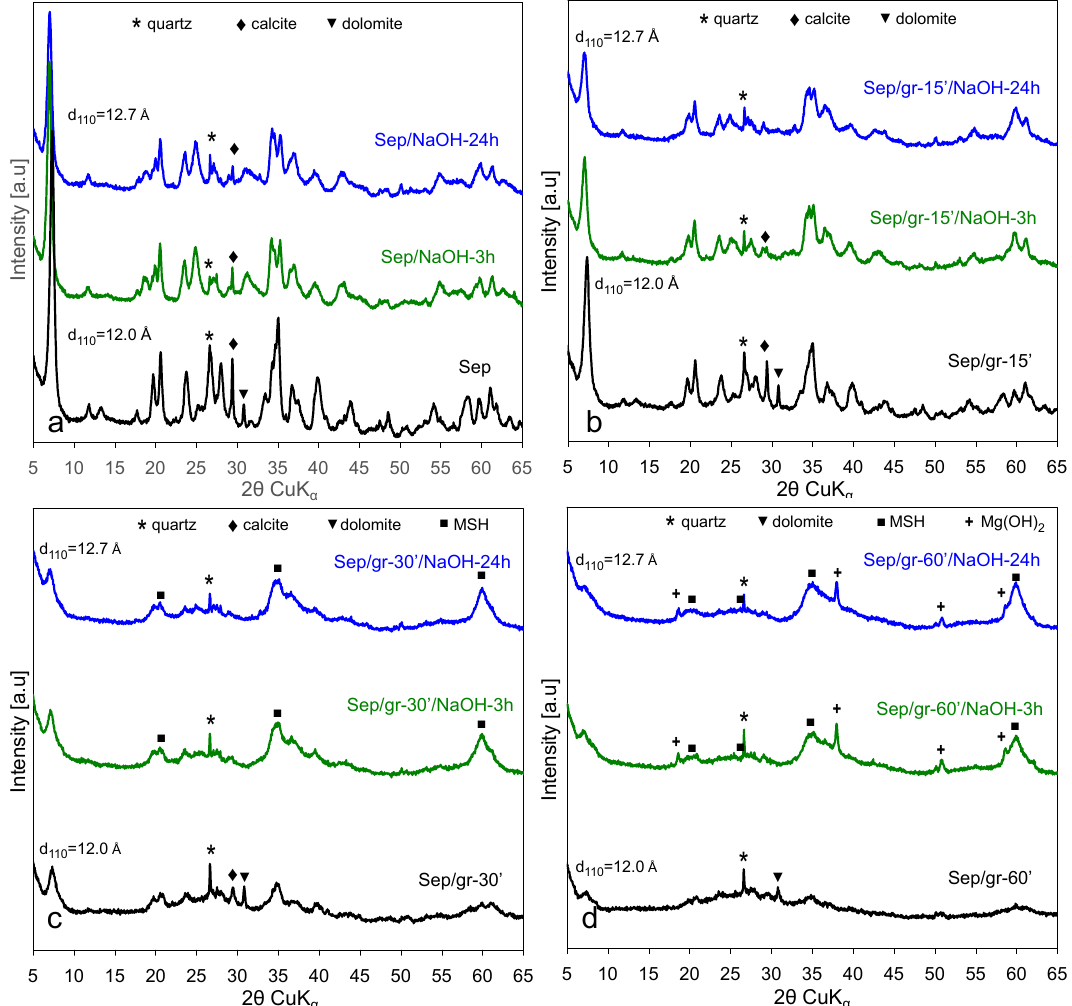
Figure 4. Effect of treatment with NaOH at 90 °C for 3 or 24 h: ( a ) sepiolite as-received, ( b ) sepiolite ground for 10 min, ( c ) sepiolite ground for 30 min, ( d ) sepiolite ground for 60 min.